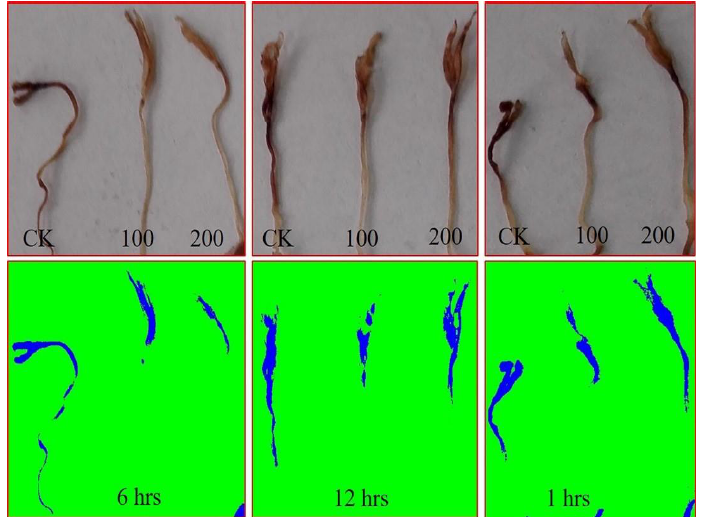
Figure 3. H 2 O 2 abundance in tomato under 50 mM NaCl. Tomato seeds were primed with 0, 100, and 200 µg ∙ mL − 1 AGE for 1, 6, and 12 h and germinated under 50 mM NaCl stress. The abundance of H 2 O